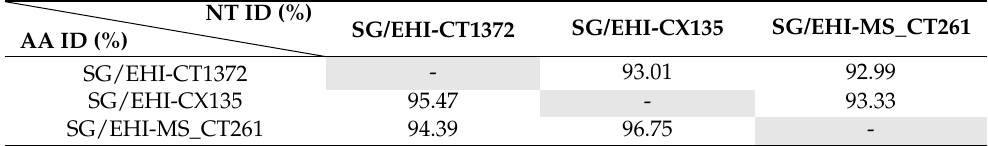
Table 4. Percentage nucleotide and amino acid sequence similarity of the polyprotein sequences of three study isolates. Nucleotide sequence identities (NT ID) are in the upper right triangular area above the shaded cells and amino acid sequence identities (AA ID) are in the lower left triangular area.